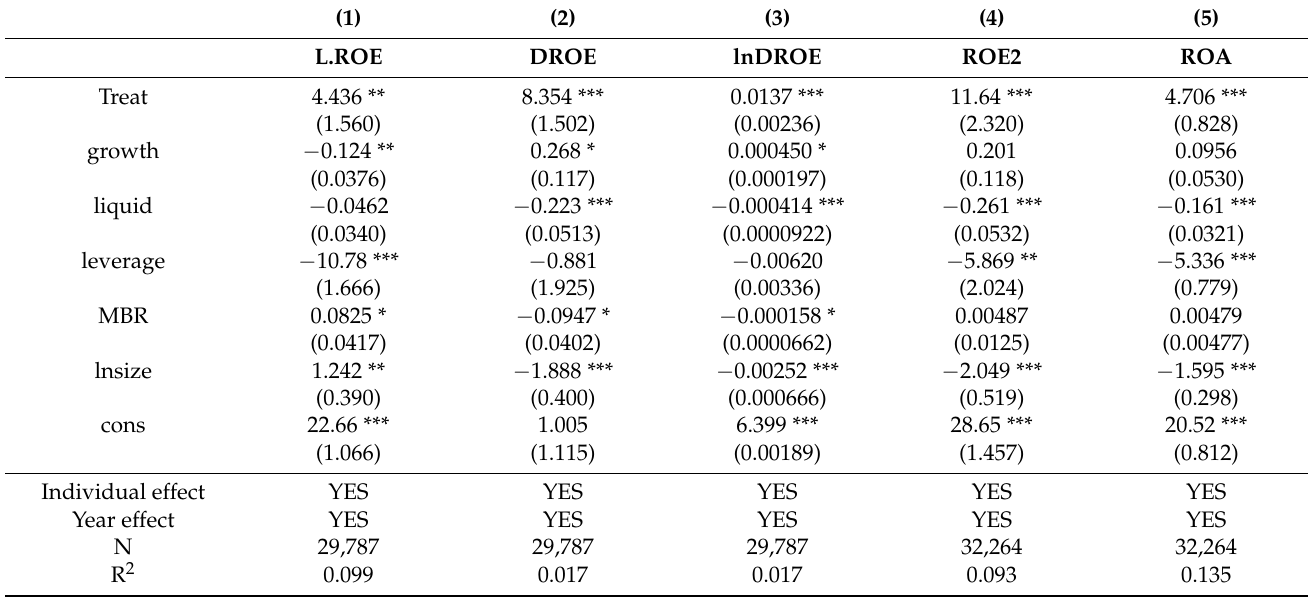
Table 6. Robustness test of replacement dependent variable.